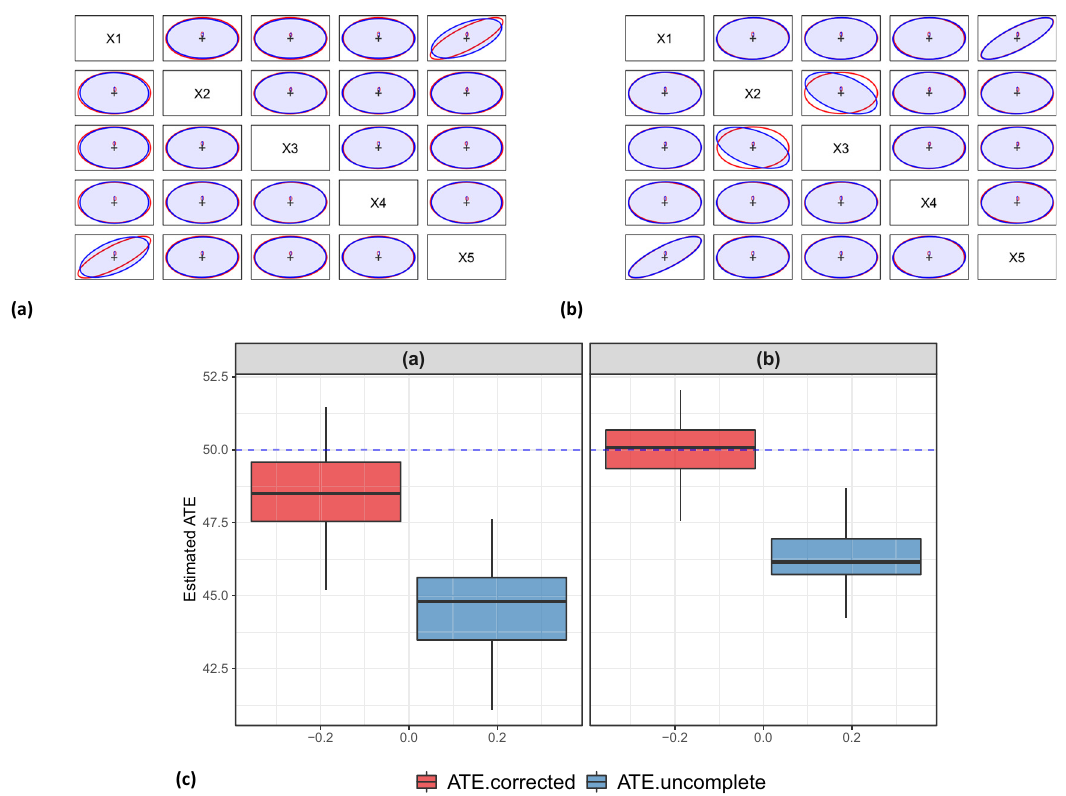
Figure A5: E ff ect of a di ff erent variance – covariance matrix on the ATE estimation , where heterogeneity between the two variance – covariance matrix is introduced as presented in ( a ) and ( b ) . ( c ) The impact on the estimated average treatment e ff ect ( ATE ) . Situations A and B result in a similar statistics when using a Box - M test, but leads to very di ff erent impact on the bias estimation as visible on ( c ) . The simulations are repeated 50 times, with a similar outcome generative model as in ( 8 ) ,